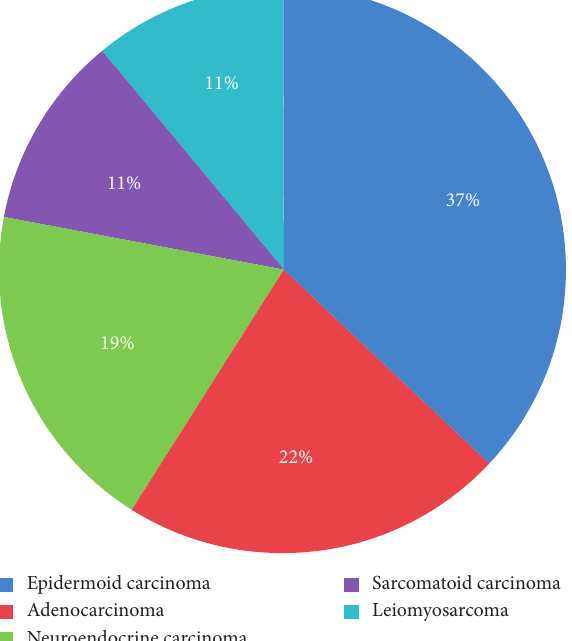
Figure 4: Distribution of cases collected in the department according to the histological type.